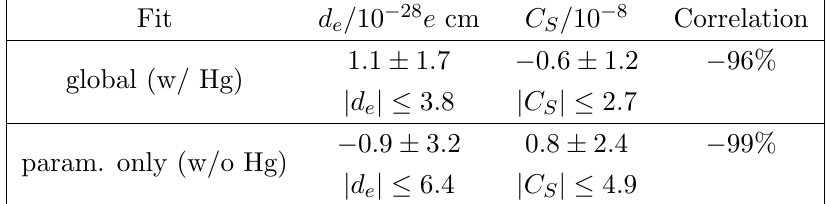
Table 5 . Fit results for the global (cid:12)t, using our result for Hg, and the (cid:12)t using only the results from paramagnetic systems. The former yields limits about a factor of two stronger than the